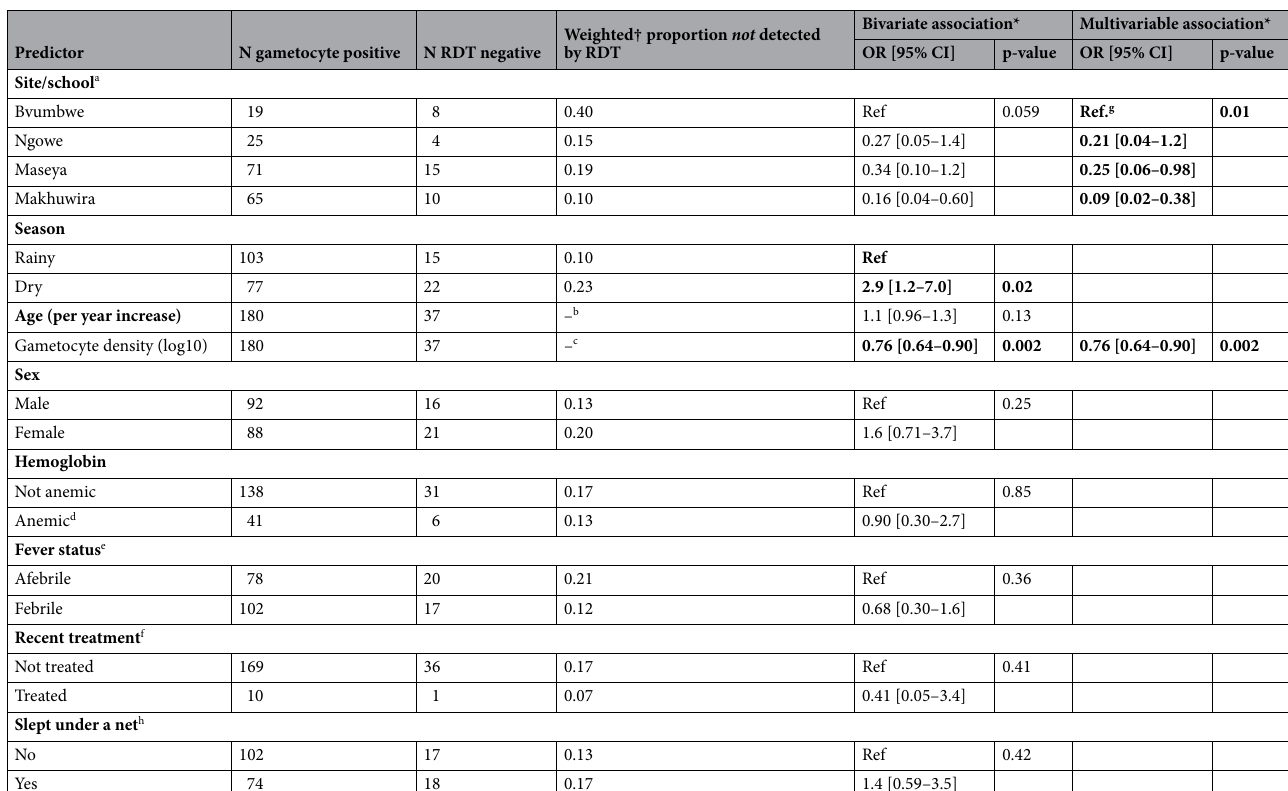
Table 3. Characteristics of gametocyte containing infections missed (not detected) by RDT screening at baseline. † Survey weights were calculated for each stratum, defined as each grade within each school (details in Supplemental Information). * Obtained in a survey weighted logistic regression of gametocyte-containing infections with the outcome of RDT negativity. All analyzed variables are shown in the table. OR = Odds Ratio; CI = Confidence Interval. Bold values are statistically significant for p-values < 0.05. a Univariate association for school, all other associations include school. Prevalence setting: Bvumbwe-low, seasonal; Ngowe-moderate, seasonal; Maseya-high; Makhuwira-high. b Mean age of students with gametocyte containing infections not detected by RDT was 11.5 compared to 10.8 years for students with gametocyte containing infections detected by RDT. c Among students with gametocyte-containing infections not detected by RDT, the mean log gametocyte density was − 2.417 compared to a mean log gametocyte density of − 0.825 among students with gametocyte-containing infections detected by RDT. d Hemoglobin < 11.0 g/dL; 1 missing observation. e Measured temperature ≥ 37.5 °C at baseline visit or reported in the last two weeks. f Reported in the last two weeks; 1 missing observation. g Adjusted OR for Bvumbwe compared to all other schools in the multivariable model is 6.6 [95% CI: 1.9–24], p = 0.004. h 4 missing